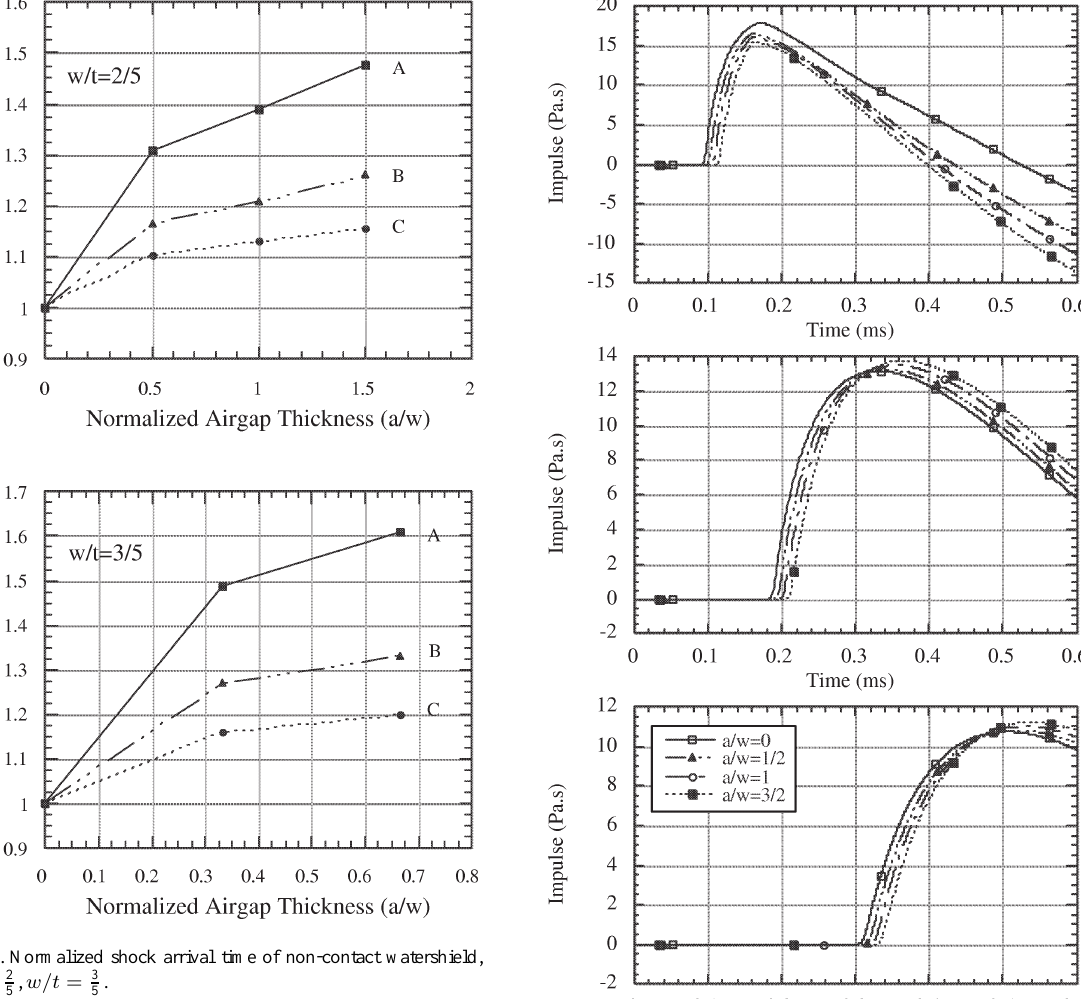
Fig. 11. Impulses calculated at A, B, and C for w=t = 2 1 , 1, 3 2 2